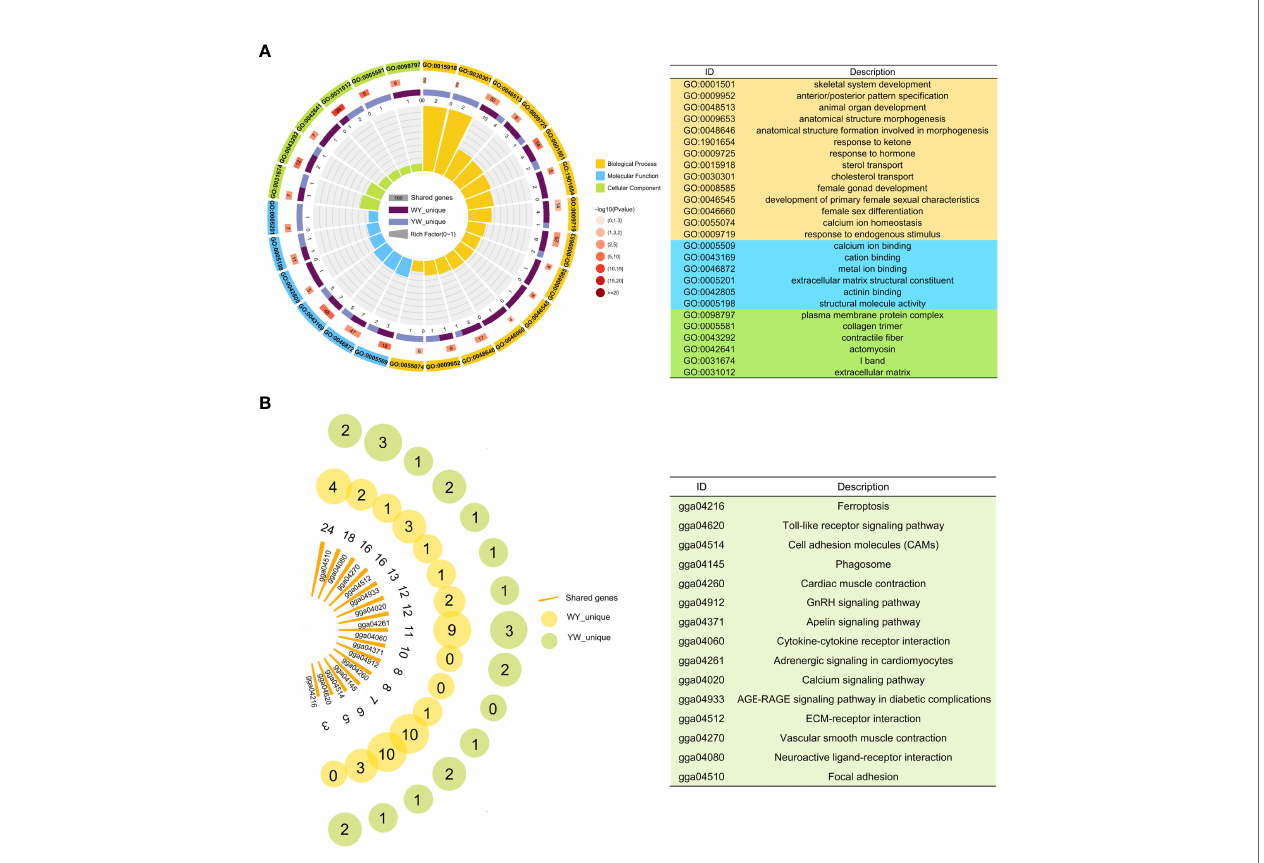
FIGURE 4 | Function enrichment analysis of nonadditive genes. (A) Signi fi cant GO terms of nonadditive genes in crossbreeds. From outer to inner, the outermost circle represents the IDs of enriched GO terms. The names of GO ID in orange, blue and green represent biological process, molecular function and cell composition respectively. The second circle indicates shared genes enriched in GO terms. In the third circle, the piece in dark purple and light purple represents unique genes of WY and YW, respectively. In the innermost circle, each bar represents one GO term, and the size represents the rich factor. (B) KEGG pathway analysis for nonadditive genes. Each bar represents one pathway and the size represents the number of shared genes. The yellow and green circle represents the unique genes in WY and YW of each pathway,